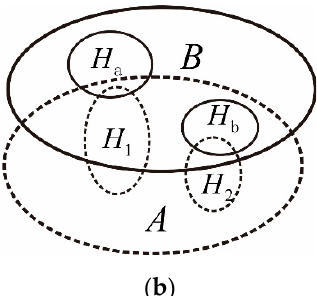
Figure 2. Components in the practical definition of regions with holes.